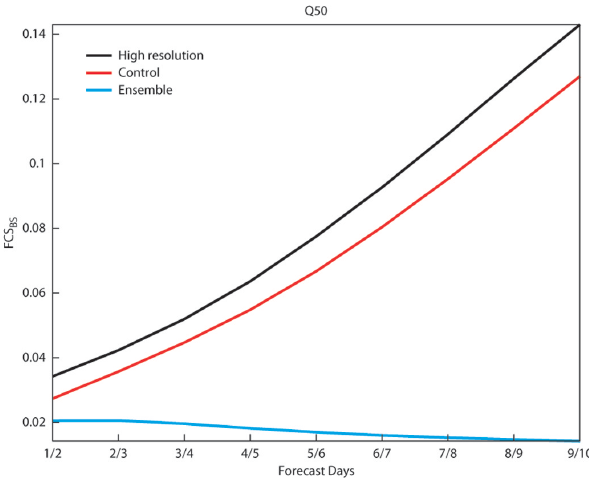
Fig. 2. Comparison of FCS BS over different lead times and fore- casts driven by different NWP systems for the Q 50